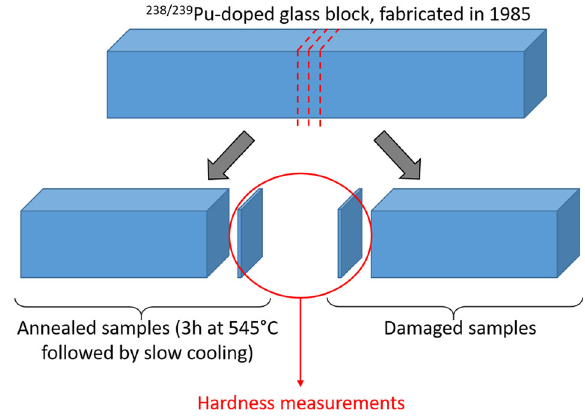
Fig. 7 Schematic view of the annealing of a part of the 238/239 Pu- doped glass. The monoliths were polished to micron range roughness on one